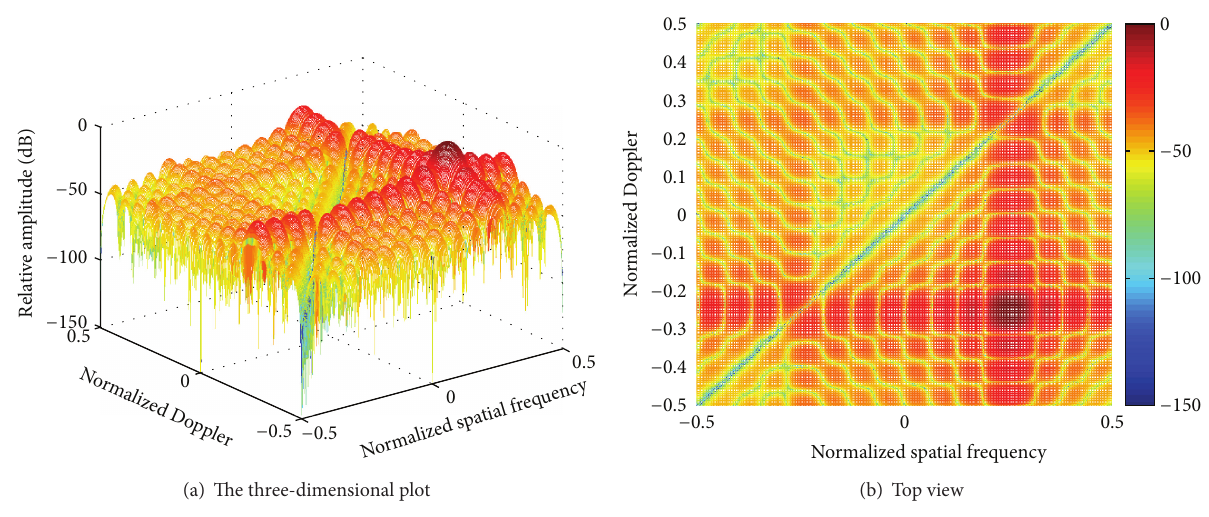
Figure 4: Cognitive space-time (angle-Doppler) transmit pattern for side-looking